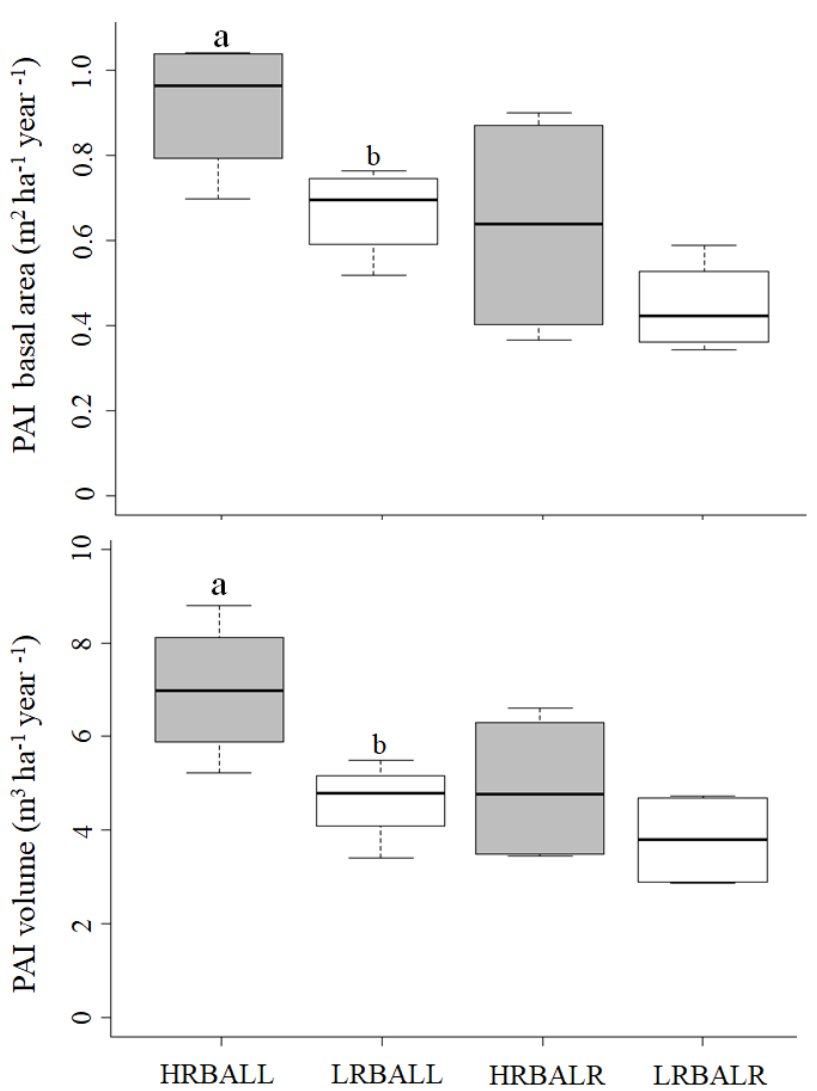
Figure 4. Pai for the net basal area and volume according to treatment (HRBA, LRBA) and site (LL, LR). Di ff erent letters between the same site show significant di ff erences ( p -value < 0.05). Boxes represent the interquartile range (IQR, Q3 minus Q1), including the median of the data, and whiskers include the remaining data.